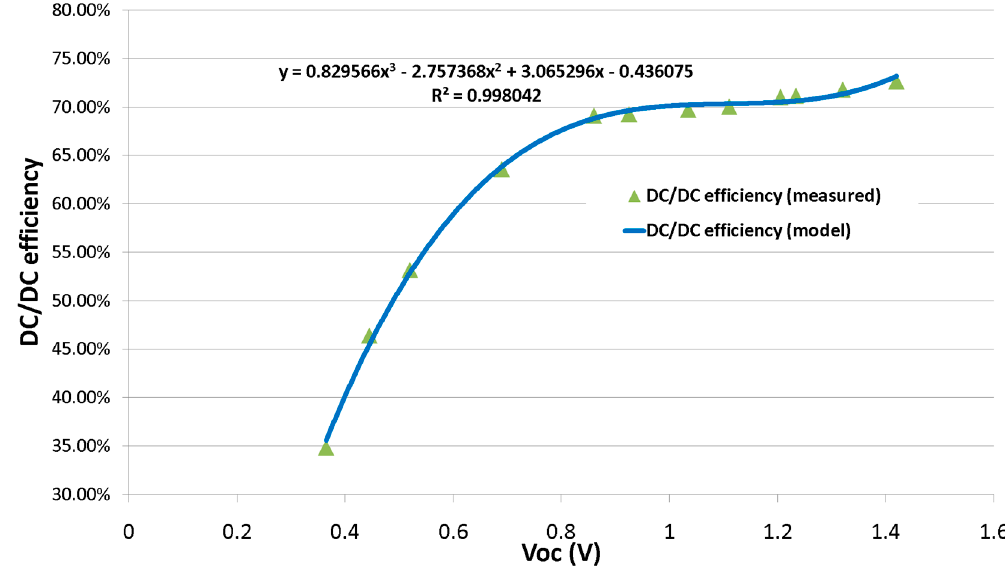
Figure 7. DC/DC efficiency vs. open circuit input voltage.